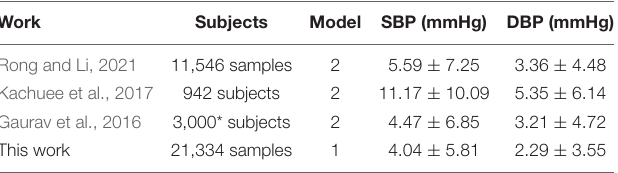
TABLE 6 | Comparison of No. model for BP evaluation between our and previous work. Work